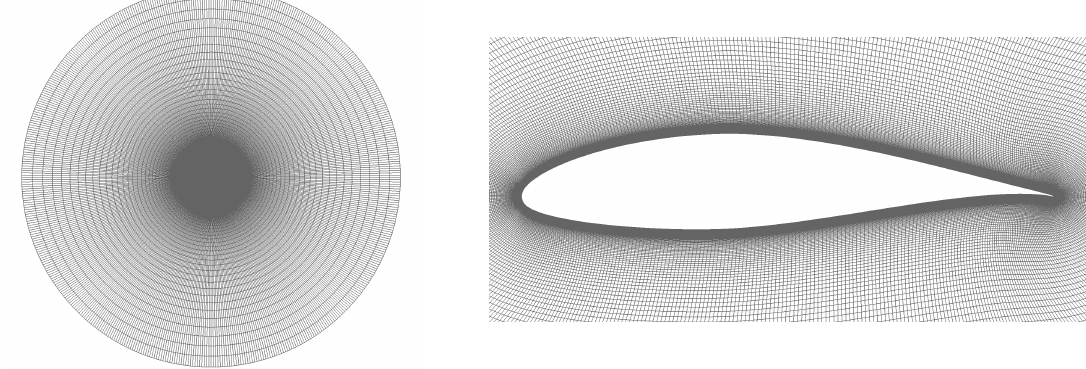
Figure 1. Complete domain and close-up view of the mesh for a NACA